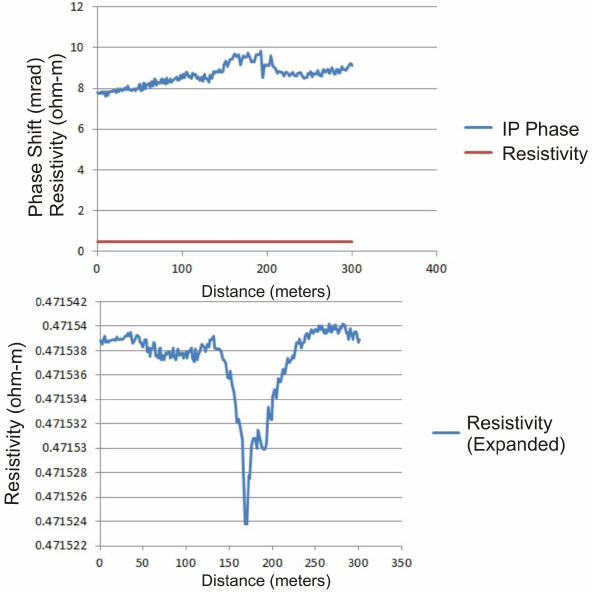
Fig. 5. The resistivity and phase shift (IP) signature of buried metal- lic debris east of Cat Island, south of Biloxi, MS, in the Gulf of Mexico. The resistivity here is higher than the seawater average due to the cable being towed directly on the water–seafloor